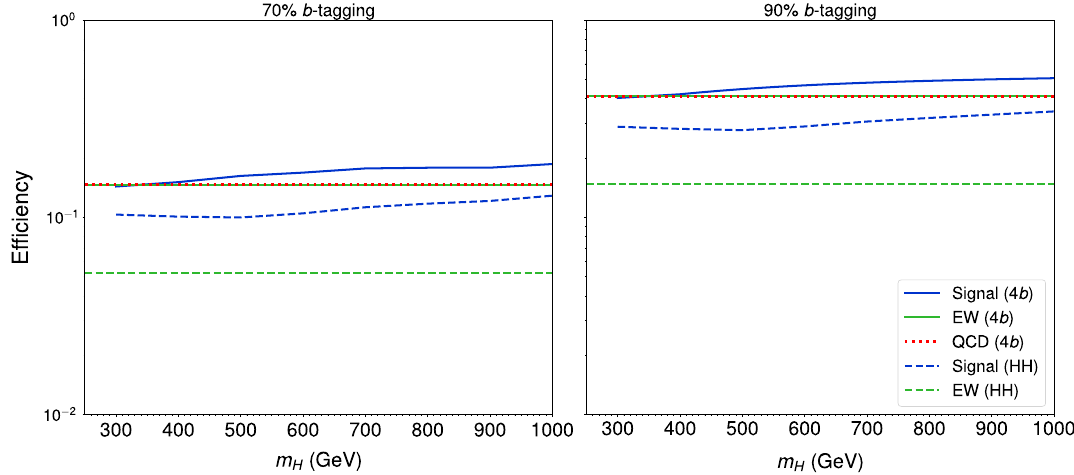
Fig. 8 Signal (blue), EW background (green) and QCD background (red) efficiency after b -tagging (4 b , solid/dotted) and SM Higgs candidate selection (HH, dashed) as a function of m H (see text for details) Table 3 UP: 3 TeV CLIC cross section (in fb) for signal (for m H = 300, 600, 900 GeV respectively) and SM backgrounds for a b -tagging efficiency of 70%, at different stages in the event selection and in the signal region (SR) for m H = 300, 600, 900 GeV respectively (see text for details). DOWN: Same as above, for a b -tagging efficiency of 90%